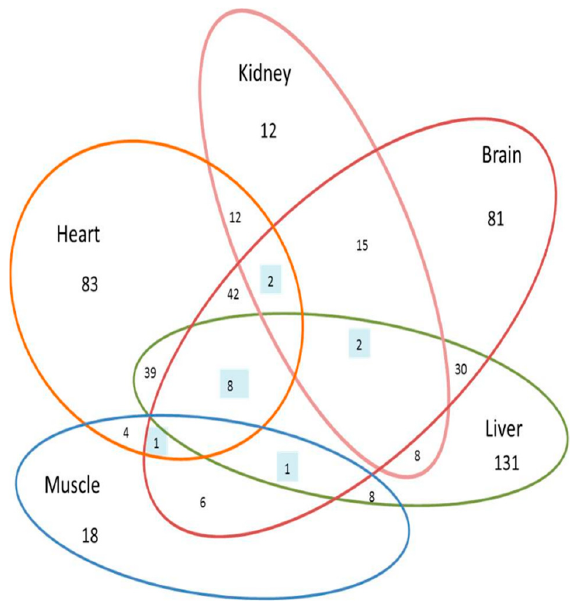
Figure 3. Organ-specific proteome expression: Venn diagram representation of the differentially expressed significant proteins ( p ≤ 0.05, 1.5 fold change) identified within the morphologically altered organs from Dex-treated and control animals. Number of proteins expressed in common among various organs are shown in the intersections. The number of proteins specific for each organ namely the heart ( n = 83), kidney ( n = 12), brain ( n = 81), liver ( n = 131), and muscle ( n = 18). The highest number of overlaps was found to be between the heart and brain ( n = 42) followed by the heart and liver ( n = 39) and the liver and brain ( f = 30), while only eight proteins were common among the three groups and no proteins were in common between the muscle and kidney. The area of the Venn diagram is not representative of the numbers of identified proteins. Table 1. This table shows the identity (gene name) of the proteins found to be overlapping between the different organs. The proteins found in common among the different organs are marked as: + common in heart, brain, liver; ++ common in heart, brain, kidney; ‡ common in kidney, heart, liver; ‡‡ liver, muscle, brain; † common in brain, heart, muscle; and †† common in brain, kidney, liver.